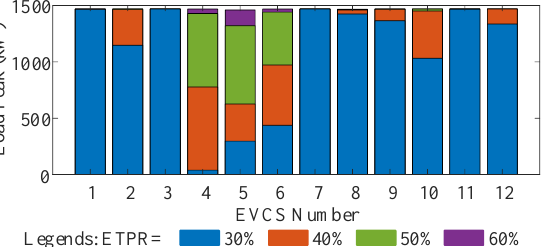
Figure 9. Comparison of peak load at the first charging peak under different ETPR.